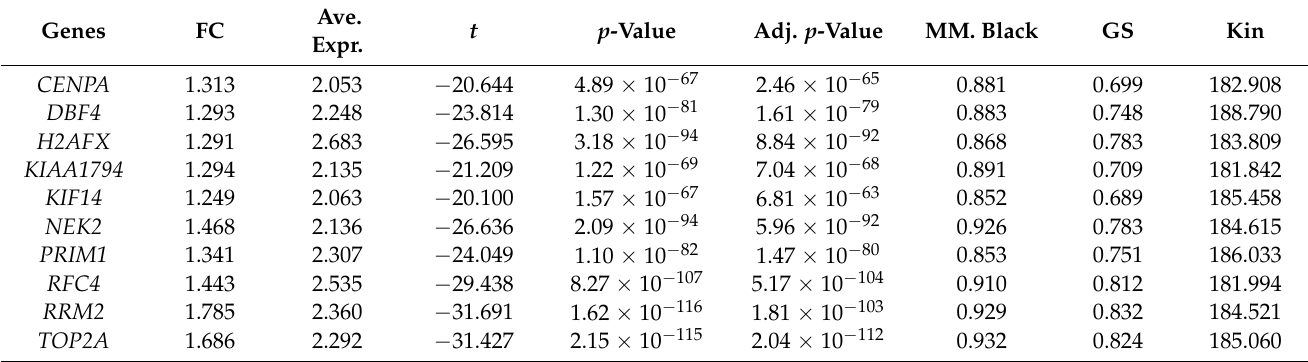
Table 2. The top ten genes with the highest intramodular connectivity.